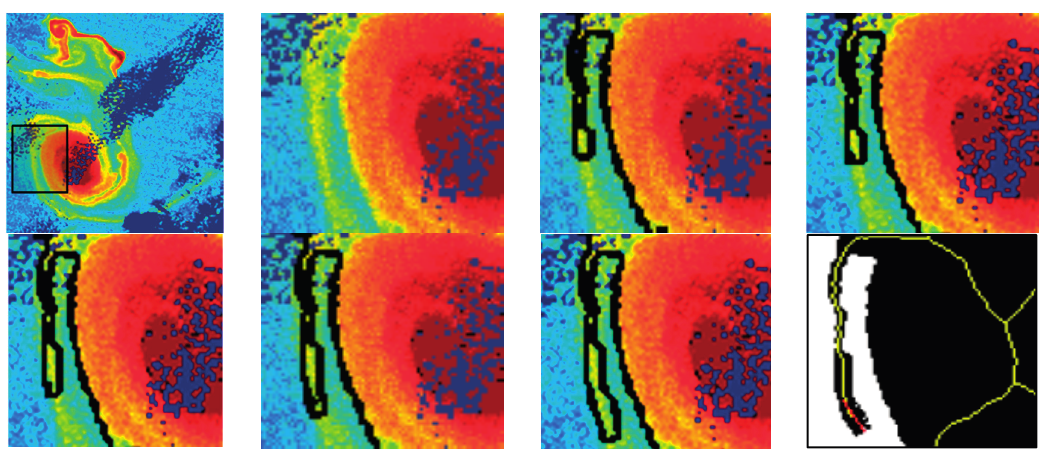
Figure 8. Some results of the iterative growing process included in the Eddy Growing Module for a particular filament. Skeleton and growing direction after the last